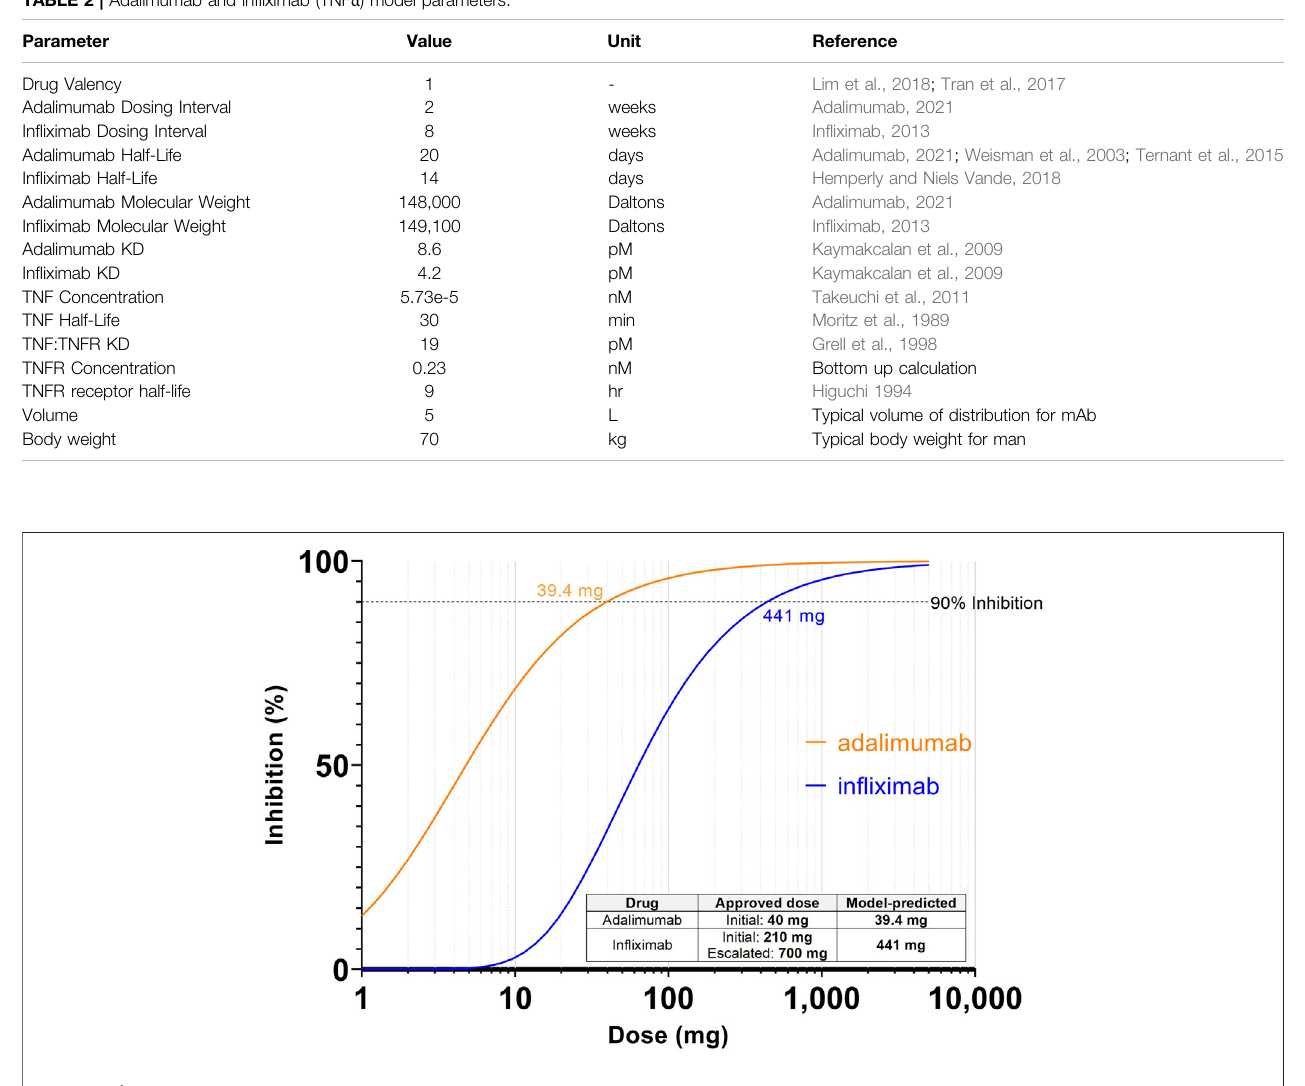
( Figure 1 ), focusing on the interaction of the soluble TNF α with drug within the vascular and interstitial fl uid.